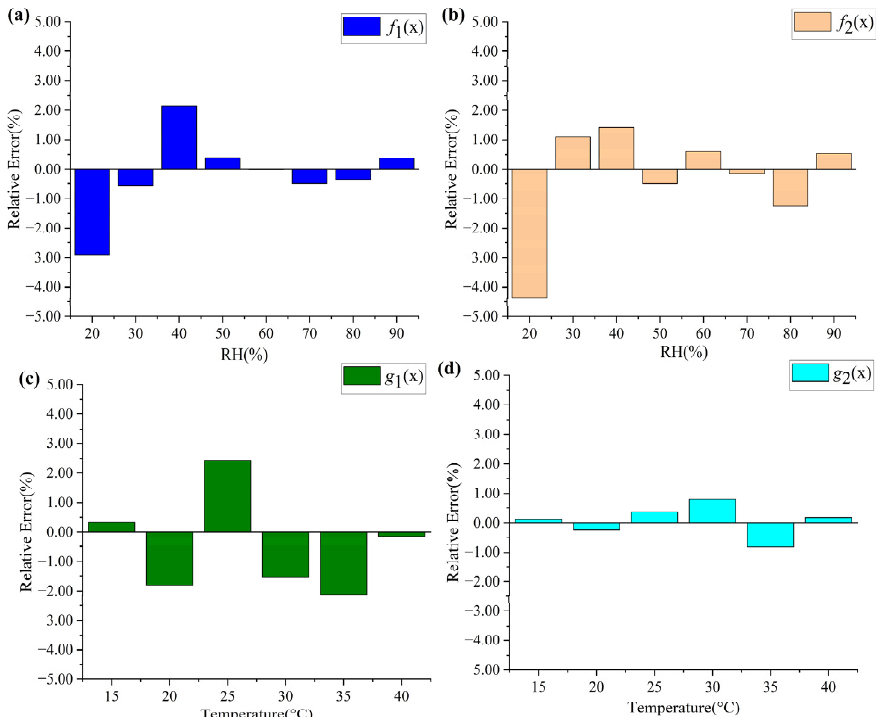
Figure 8. ( a – d ) Relative errors caused by fitting